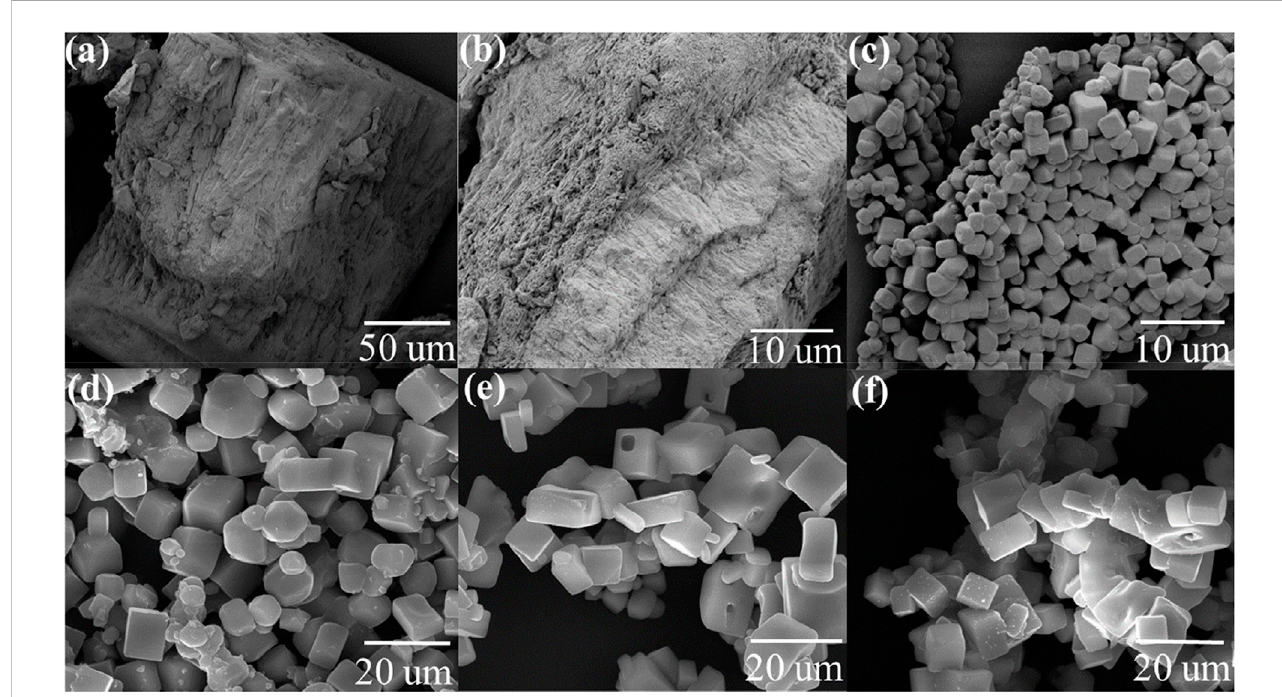
SEM images ofcuttle fi shbone: (A) pure washedCFB topdorsal part before calcination, (B) washed CFBP lamellae part beforecalcination, (C) washedCFBP calcined at 900 ° C 0.5 h, (D) washed CFBP calcined at 900 ° C 1 h, (E) washed CFBP calcined at 1000 ° C for 0.5 h, and (F) washed CFBP calcined at 1000 ° C 1 h.